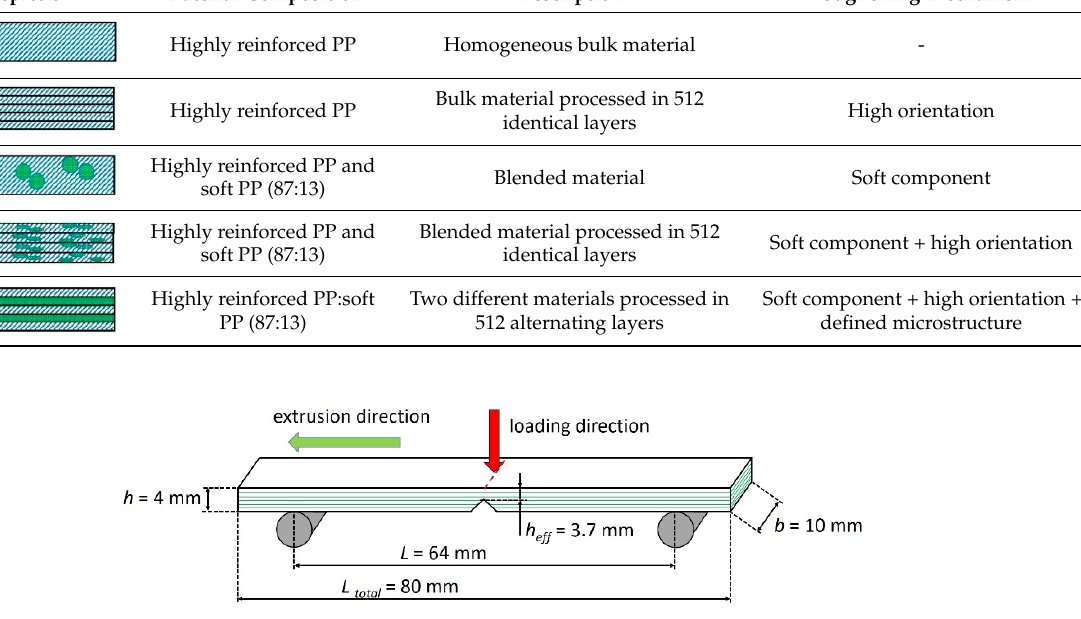
Table 1. Overview of investigated materials including their abbreviation, material composition, description and schematic of microstructure.